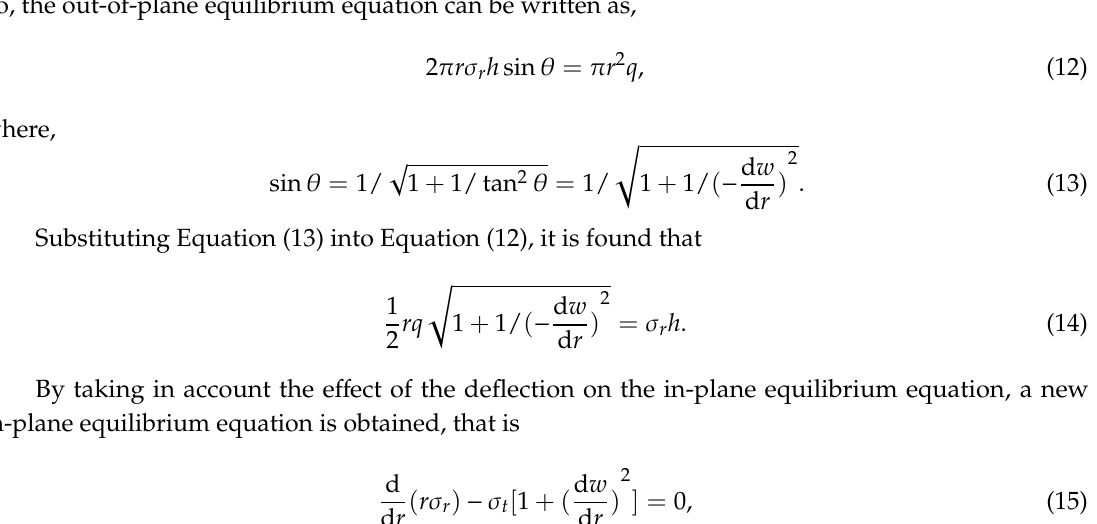
Figure 6. Sketch of the static equilibrium of the isolated-body.